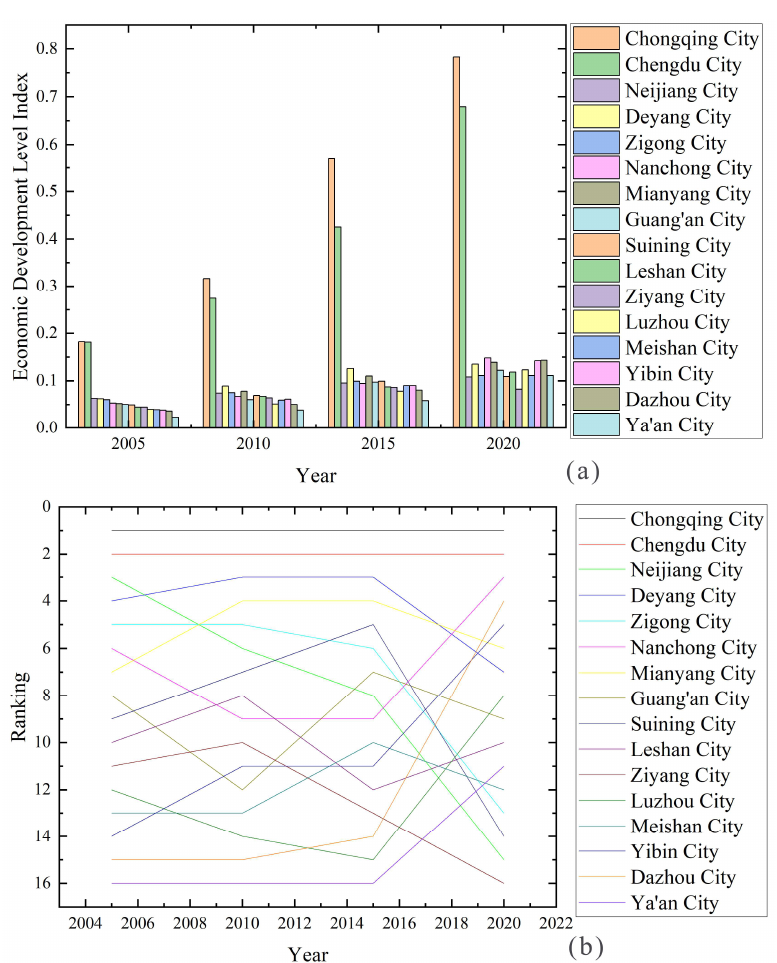
Figure 5. Economic–social development index and ranking of cities in CCCG, 2005–2020. ( a ) is a graph comparing the scores of cities. ( b ) is a graph comparing the ranking of cities.